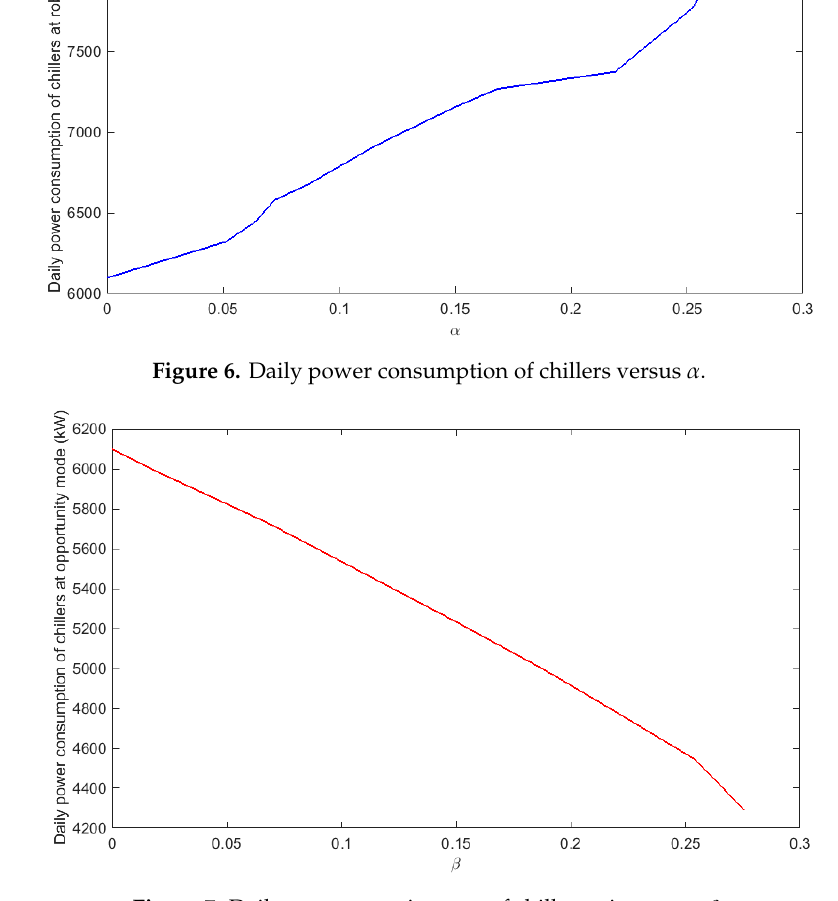
Figure 7. Daily energy requirement of chiller units versus 𝛽.